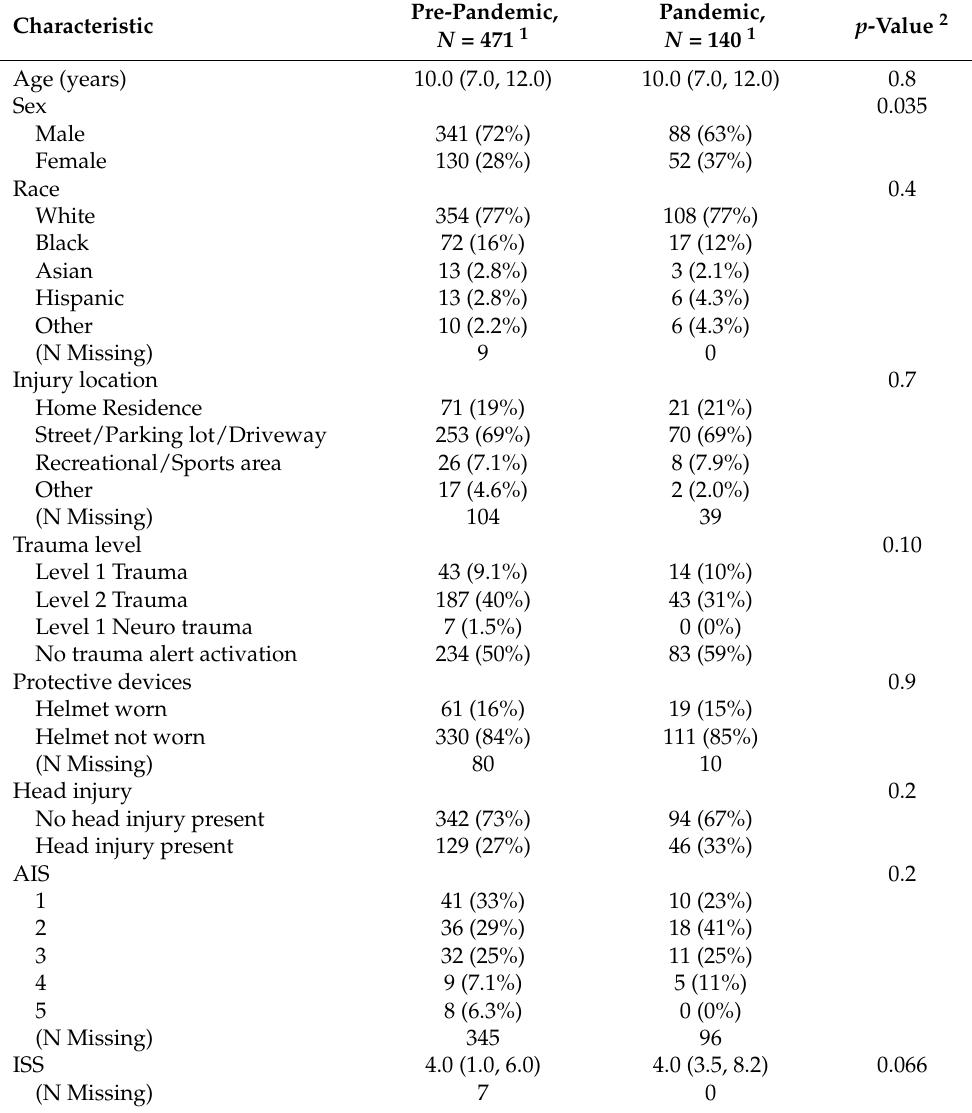
Table 1. Comparison of patient characteristics between pre-pandemic and pandemic time periods. Characteristic